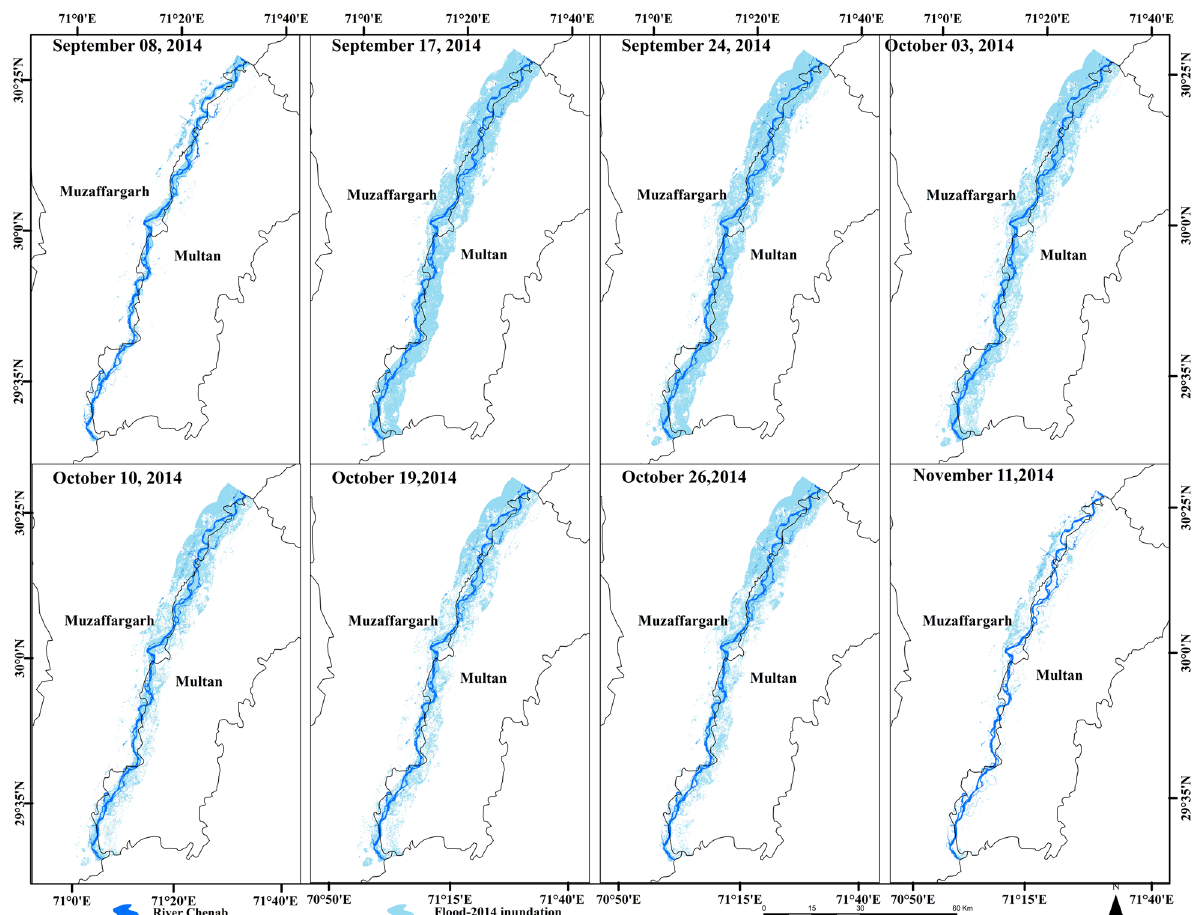
Fig. 4 Spatio-temporal flooded areas extent from pre-flood to post-flood using NDWI